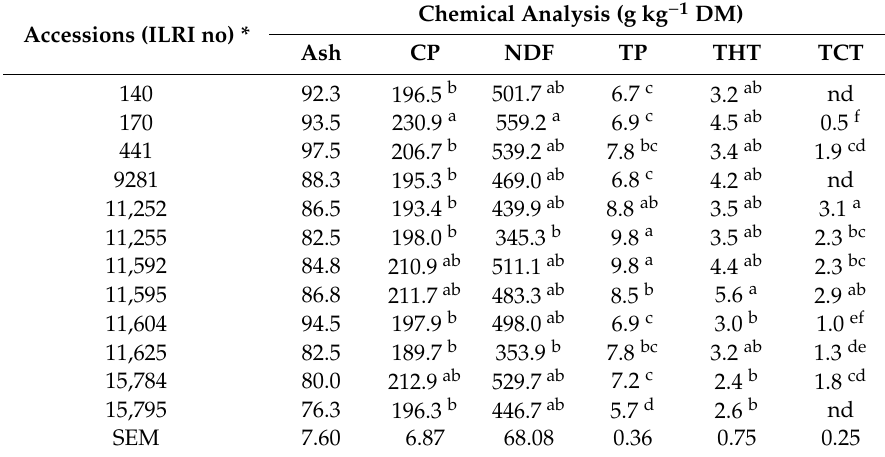
Table 5. Chemical analysis and phenolic compounds for di ff erent forages of S. scabra accessions adapted in climatic condition of Pretoria.